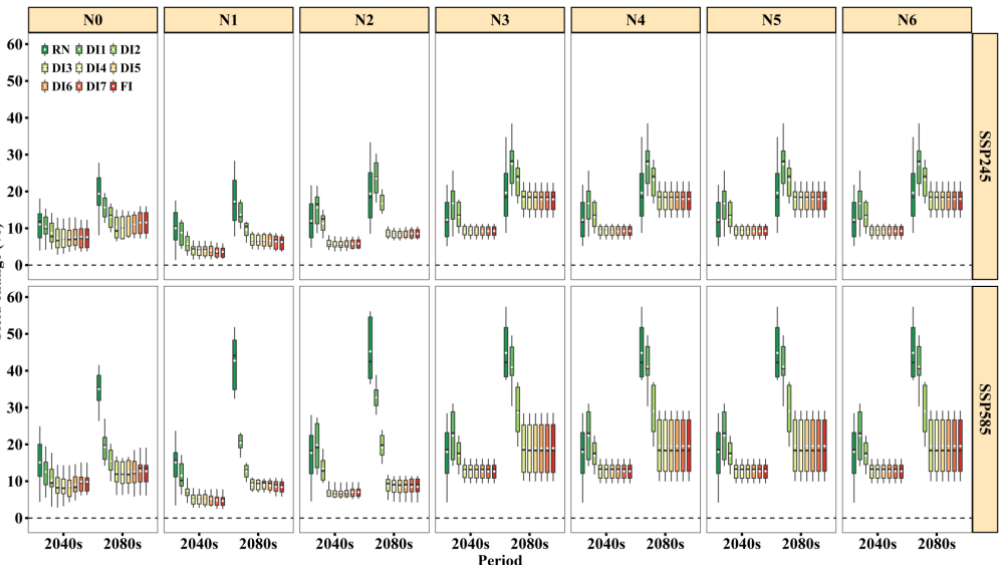
Figure 4. Yield change for nine irrigation treatments under N fertilizer rates in the 2040s and 2080s relative to the baseline (1961−2000) under SSP245 and SSP585 based on 21 GCMs. Box boundaries indicate the 25th and 75th percentiles across GCMs, and whiskers below and above the box denote the 10th and 90th percentiles. The black lines and white dots inside the box indicate the multi-model median and mean, respectively.